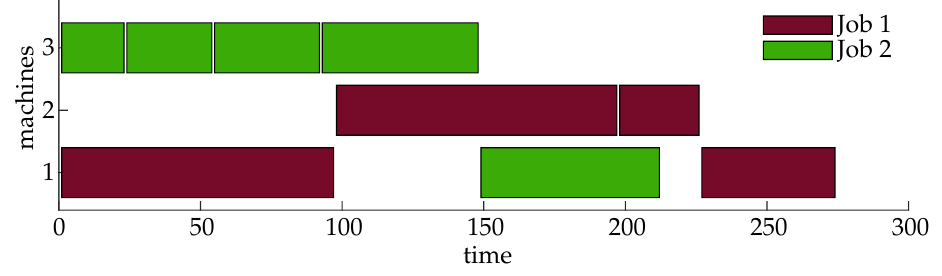
Figure 4. Gantt chart of the closed loop schedule for the small sized scheduling problem “ sops1.json ” [37], resulting from the application of the MPC (16). The medium-sized scheduling problem “ mops1.json ” has n M = 8 machines, n τ = 39 tasks and n J = 5 jobs. The MPC is parametrized with the prediction horizon N = 1 and the extended prediction horizon N + = 500. It takes approximately 35 min to simulate the MPC in closed loop for the 786 time steps that it needs to complete the production